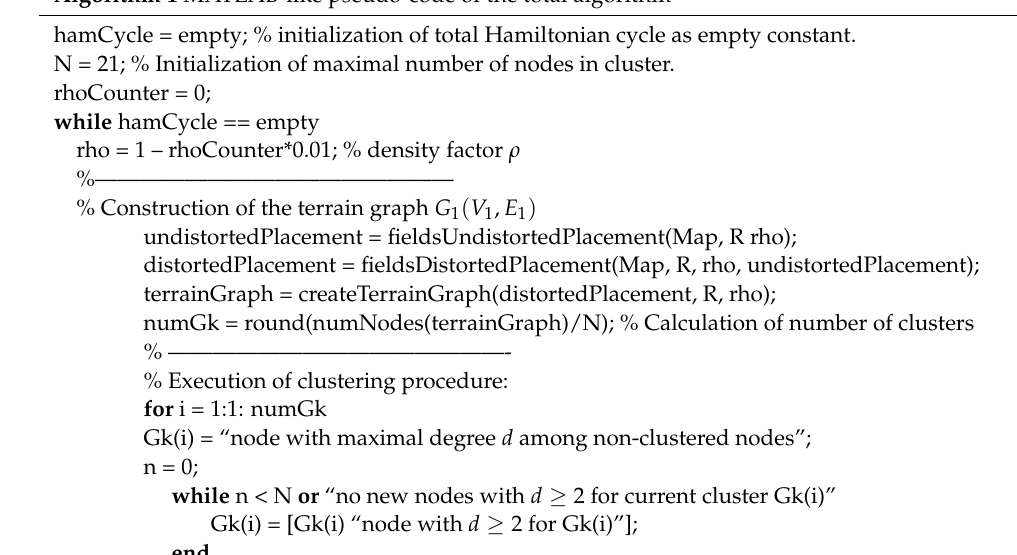
Algorithm 1 MATLAB-like pseudo-code of the total